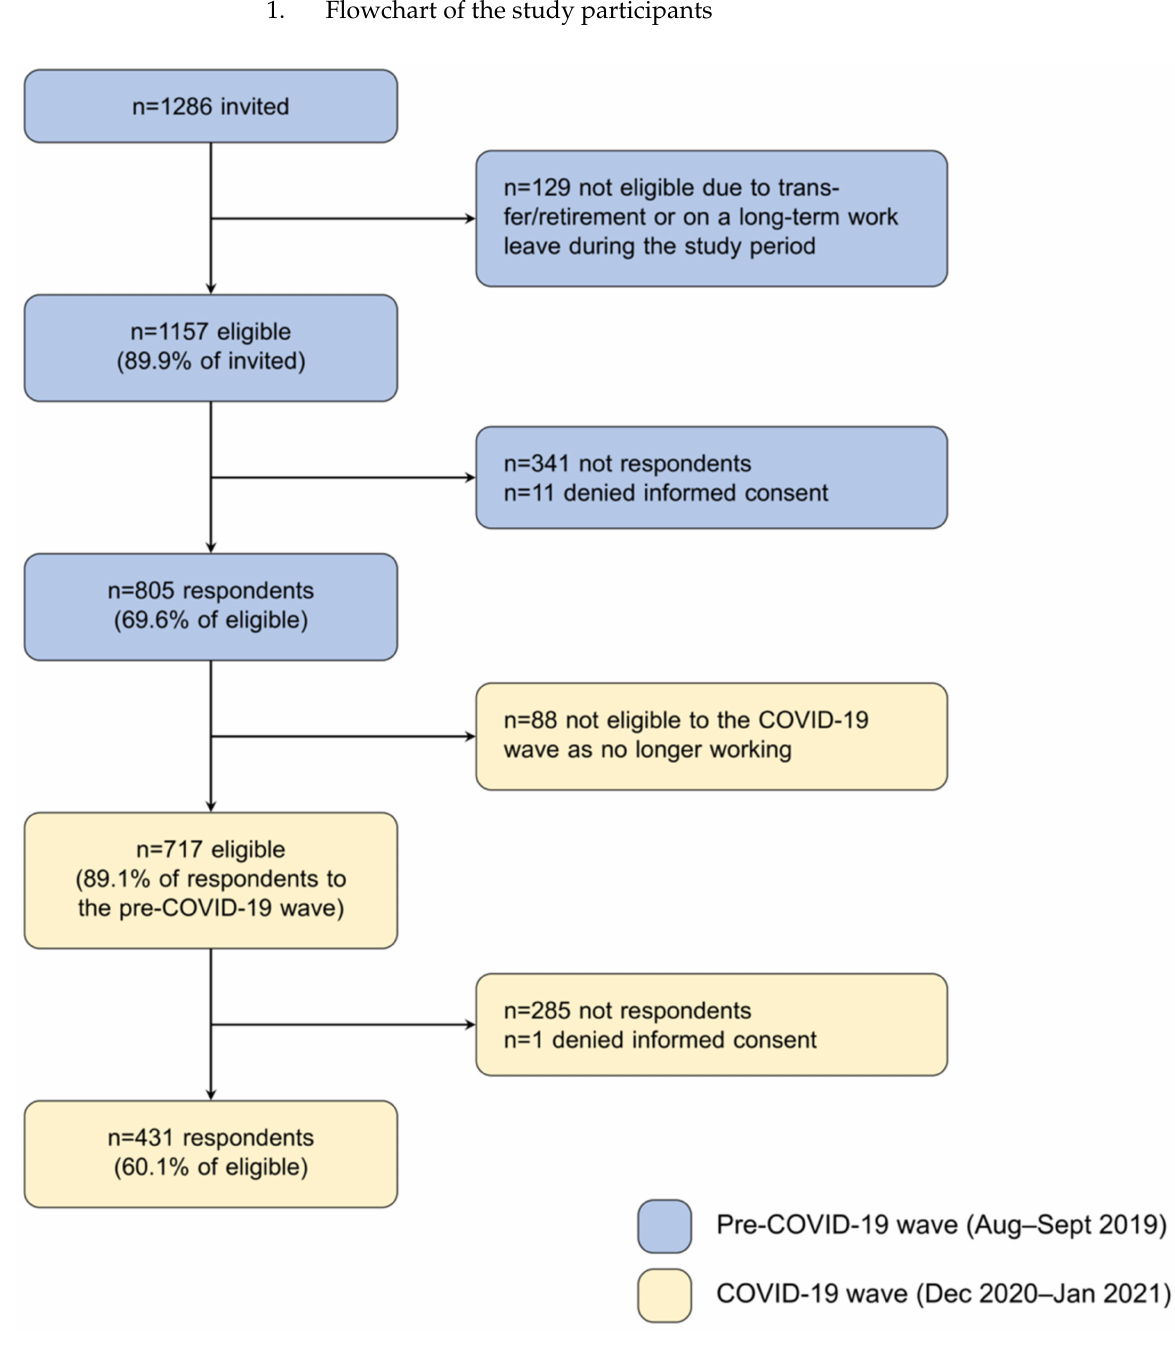
Figure A1. Flowchart of the study